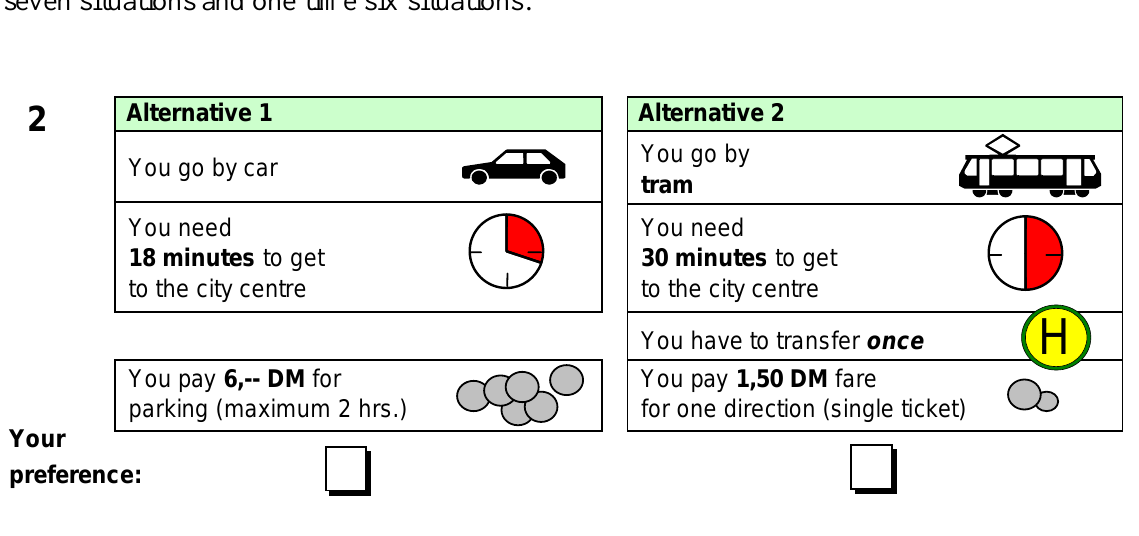
Figure 2. Example of the between-mode stated preference experiment